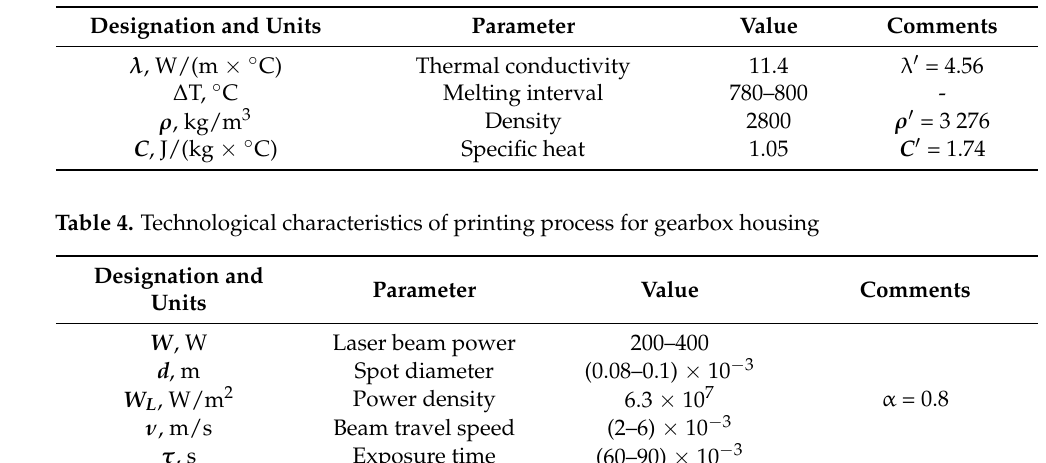
Table 3. Thermo-physical characteristics of the AlSi10Mg alloy